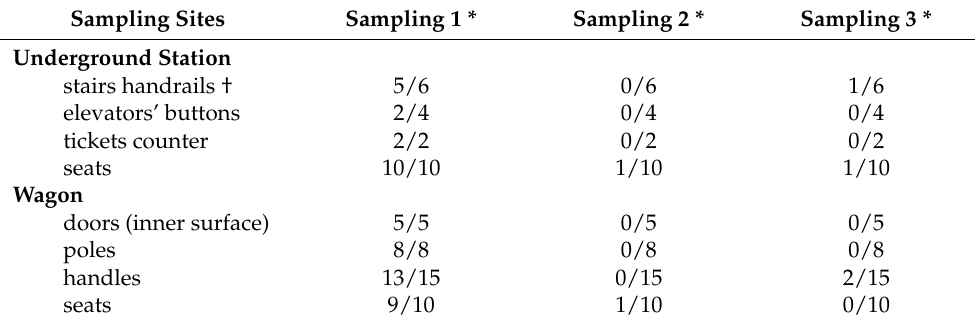
Table 1. Samples testing positive for bacteria by sampling site and phase, Athens metro. Sampling Sites